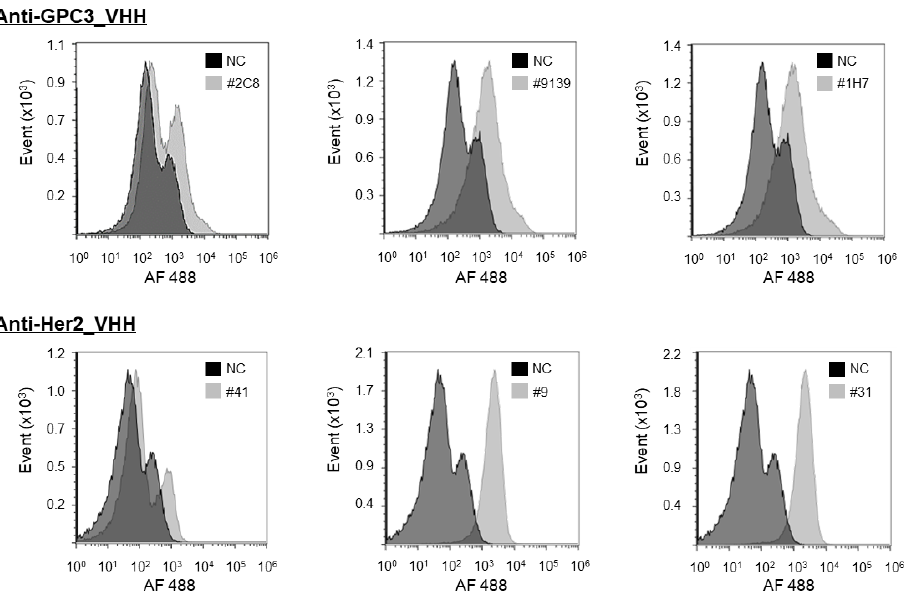
Figure 6. FCM analysis of cell-binding on SK-BR-3 (highly expressed HER2) and HepG2 (highly expressed GPC3). Anti-His-tag mAbs conjugated with Alexa Fluor 488 were used as the secondary antibody, cell binding was detected by the secondary antibody recognizing the C-terminal His tag of VHHs. Negative control (NC) was stained with secondary antibody only.